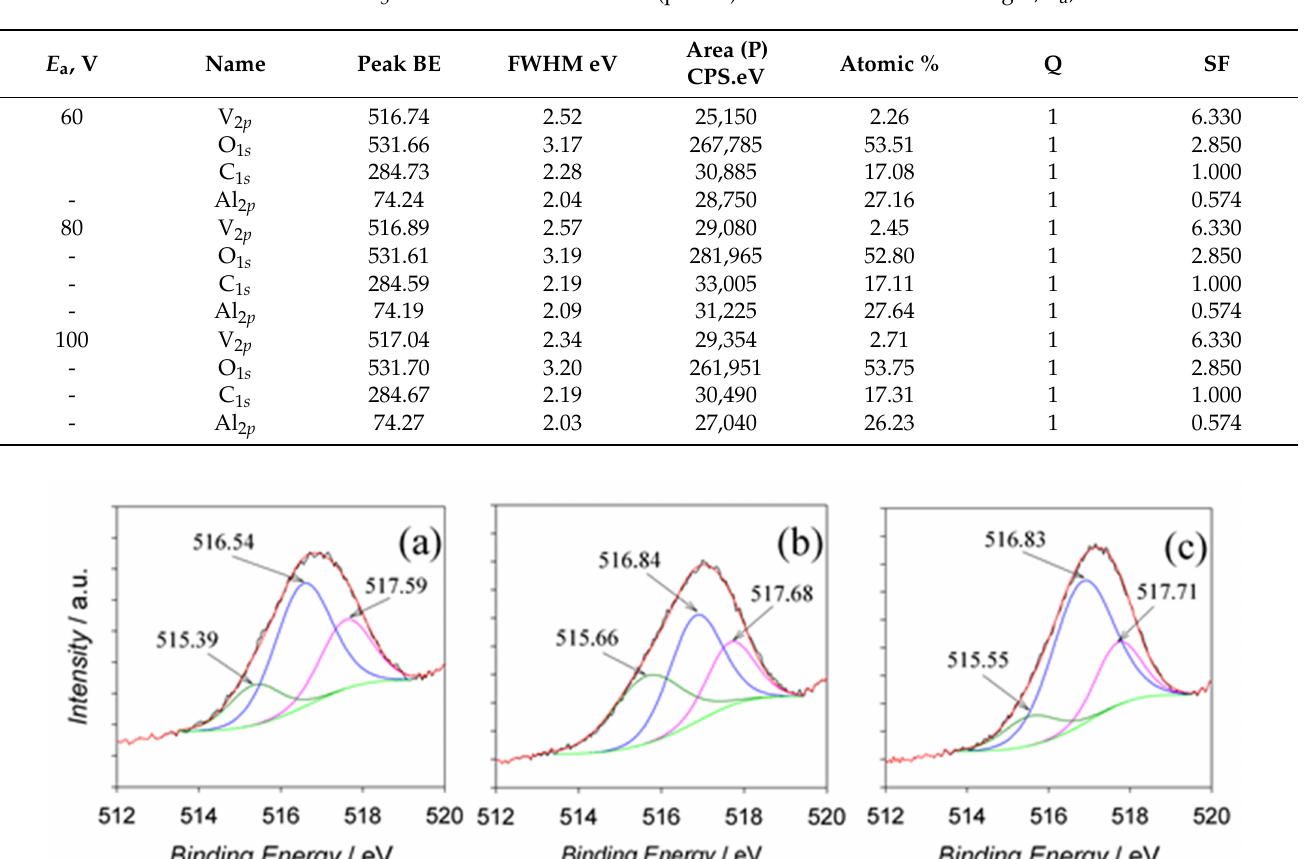
Table 1. XPS data for anodic films fabricated by Al anodization in a solution containing 0.2 mol · L − 1